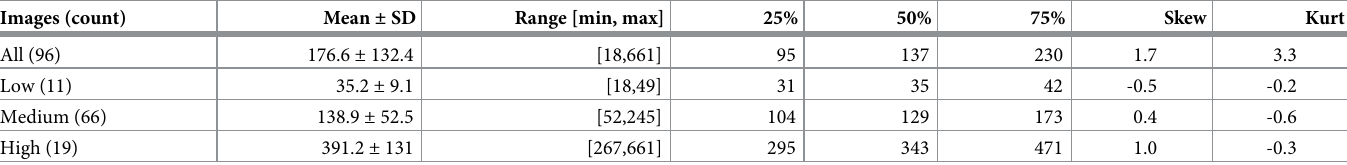
Table 1. Descriptive summary (mean, range, percentiles, skewness and kurtosis) of the cell quantities in the provided images, for the whole data set and for the vari- ous complexity levels. Images